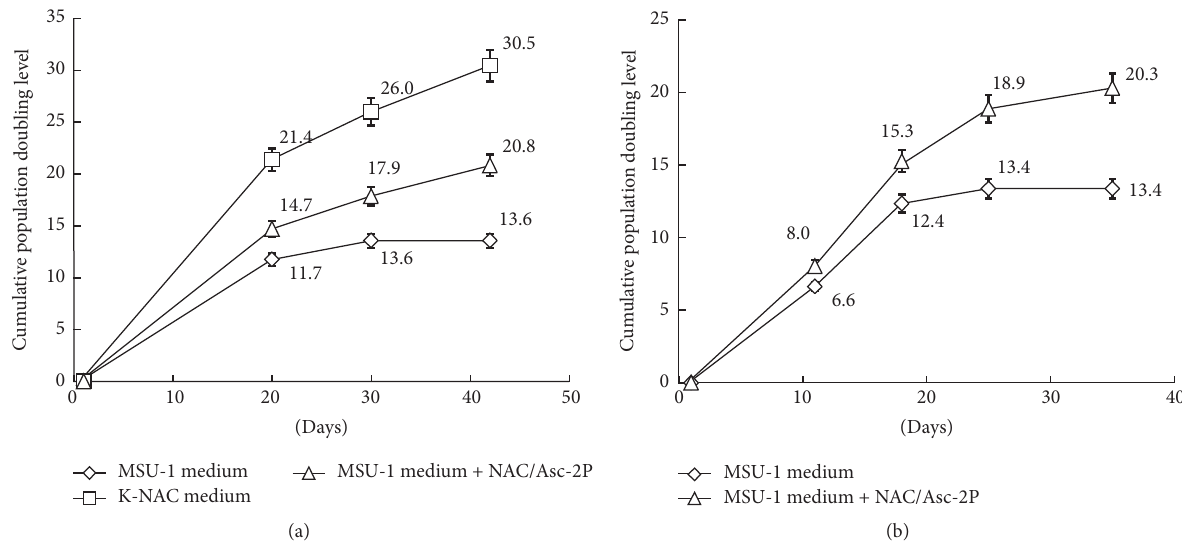
Figure 2: Antioxidants enhanced proliferation of Type I HBECs. (a) The average cpdl for HBEC30, HBEC31, and HBEC35 developed in the K-NAC medium (cpdl 30.5) was higher than that in MSU-1 medium and the MSU-1 medium with NAC/Asc-2P (cpdl 13.6 and 20.8, resp.) ( 𝑃 < 0.05 ). (b) The average cpdl of Type II HBECs developed in the MSU-1 medium with NAC/Asc-2P (cpdl 20.3) was higher than that in MSU-1 medium (cpdl 13.4) ( 𝑃 < 0.05